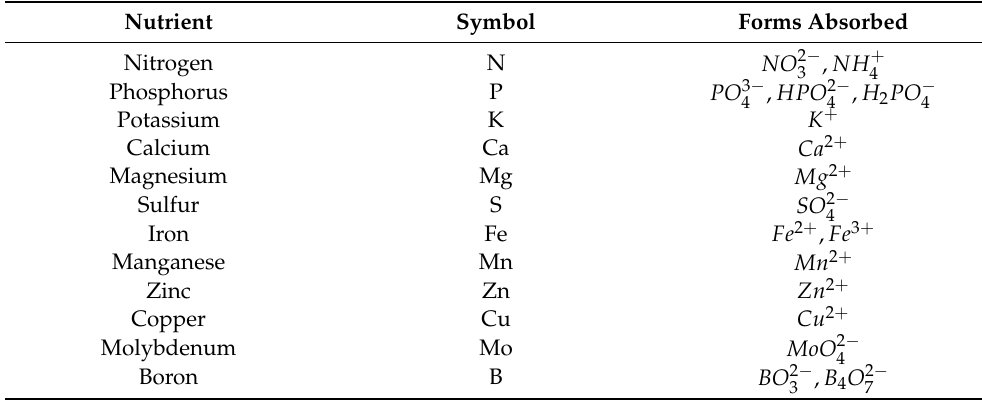
Table 3. Elements absorbed by plants